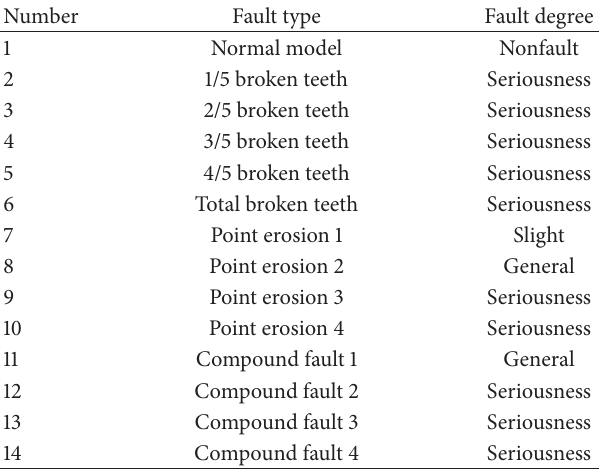
Table 1: The code of simulation faults